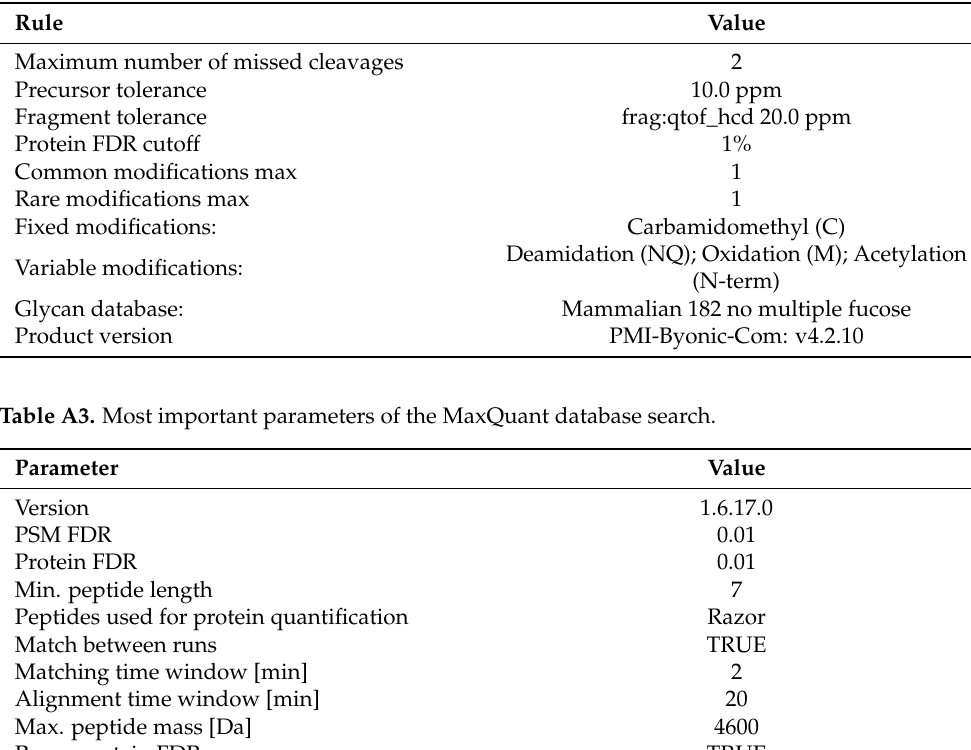
Figure A4. Average LFQ values of quantified proteins by using the presented gradient methods. Table A2. Most important parameters of the Byonic database search.